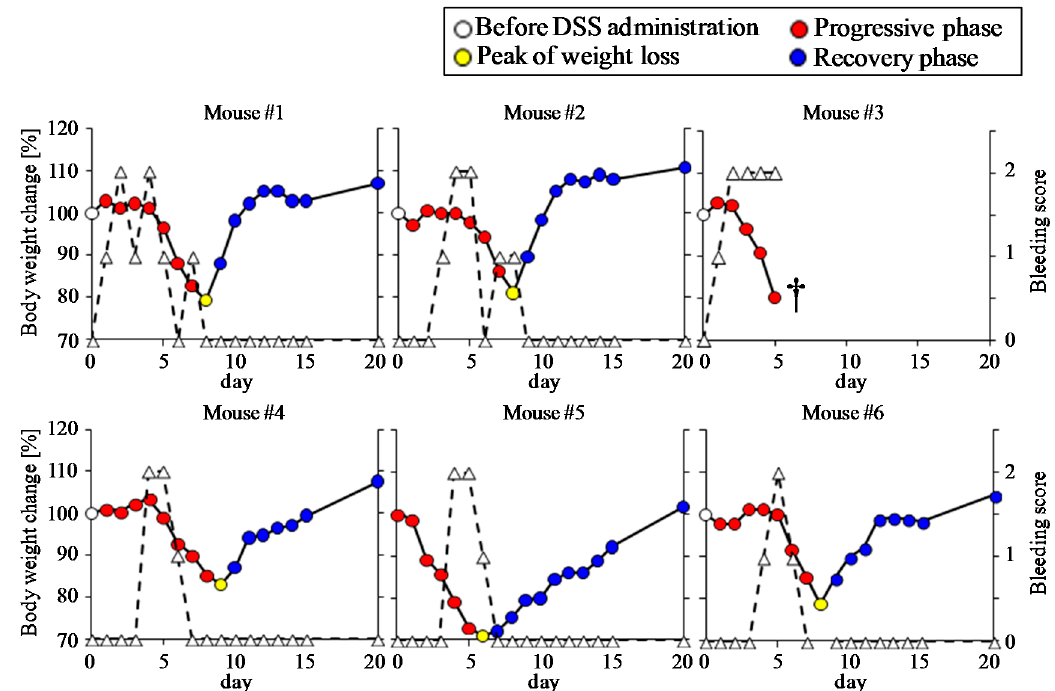
Figure 1. Monitoring of body weight changes and bleeding score of dextran sulfate sodium (DSS)-treated mice. Body weight changes (solid lines) are expressed as the percent of initial body weight. Bleeding (dashed lines) in mice was scored according to the following criteria: no bleeding, 0; bleeding, 1; gross bleeding, 2. The disease phases were categorized according to body weight changes during the experimental period: before DSS administration (phase 1, white), progressive phase (phase 2, red), a peak of weight loss (phase 3, yellow), recovery phase (phase 4, blue). One of the mice (No. 3) died on day 5 (†).